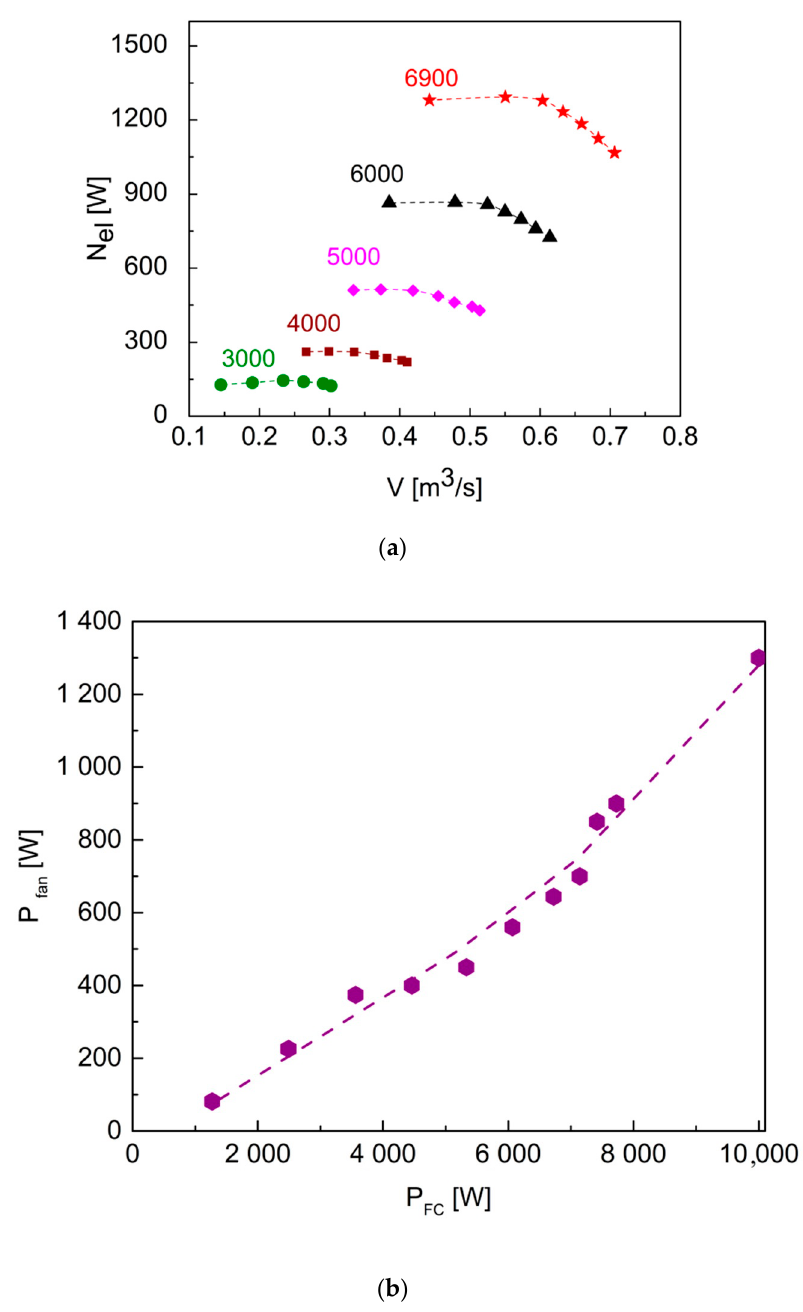
Figure 16. ( a ) Estimated electrical power N el needed to supply two constructed cascade axial fans vs. expected volumetric air flow. ( b ) Measured electrical power P fan needed to supply the cooling system vs. the electrical power produced by the PEMFC stack (P FC ).